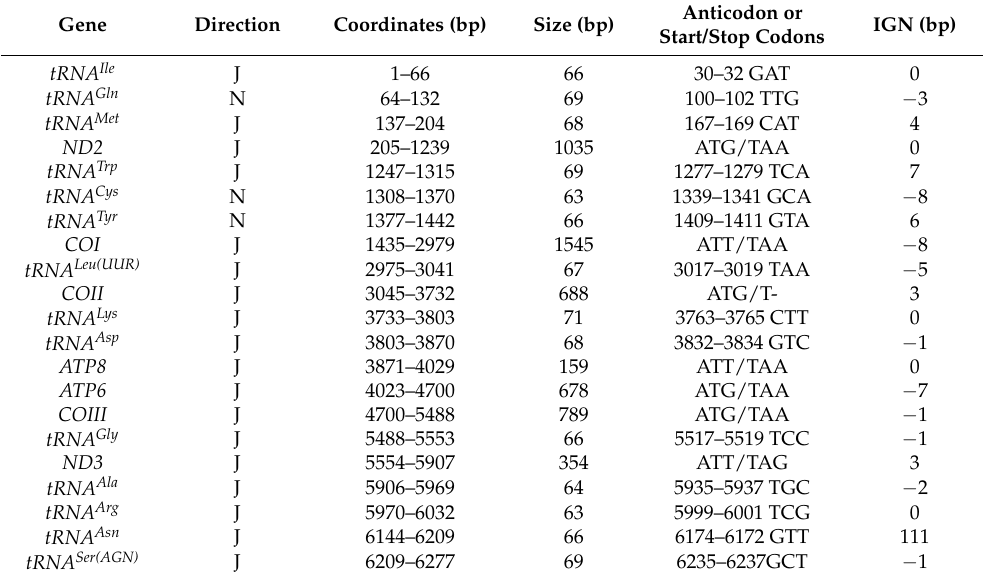
Figure 1. Map of the mitogenome of M. flexura . tRNA genes are labeled using abbreviations. The content of Guanine and Cytosine nucleotides (GC content) is plotted as the deviation from the average GC content of the entire sequence. GC skew is plotted as the deviation from the average GC skew of the entire sequence. Table 2. Organization of the M. flexura mitochondrial genome.